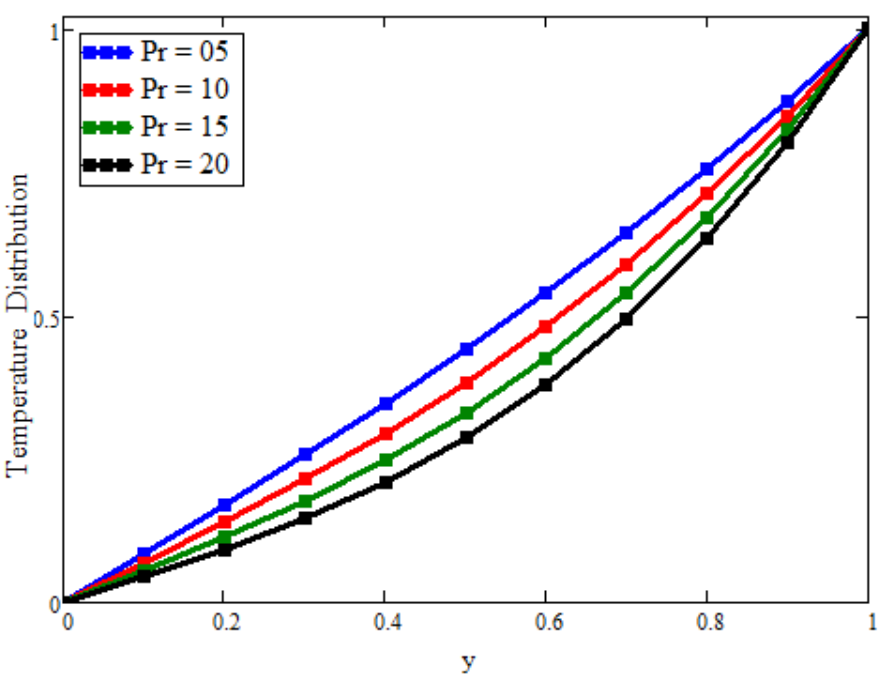
Figure 8. Temperature distribution against y due to Pr , when t = 3 , φ hnf = 0.02, α = β = γ = 0.5.